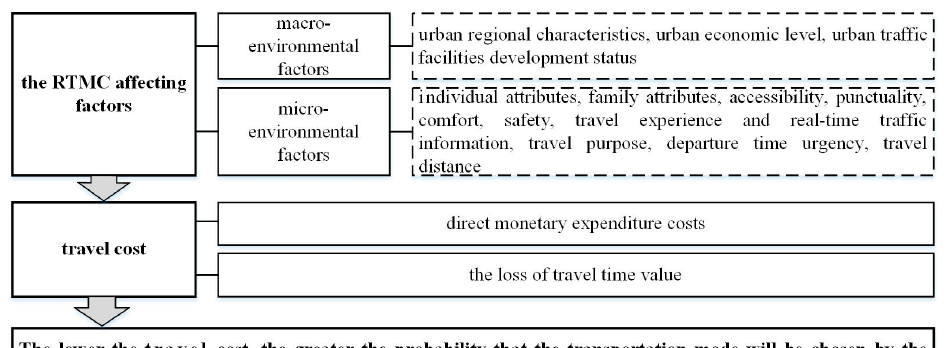
Figure 4. The RTMC probability calculation schematic diagram. Step 1: Building (cid:1845)(cid:1846)(cid:1830) (cid:3036)(cid:3037) ((cid:1865) (cid:3045) ) (Equation (14)). The (cid:1845)(cid:1846)(cid:1830) (cid:3036)(cid:3037) ((cid:1865) (cid:3045) ) is characterized by the degree of physical connection in geospatial space.